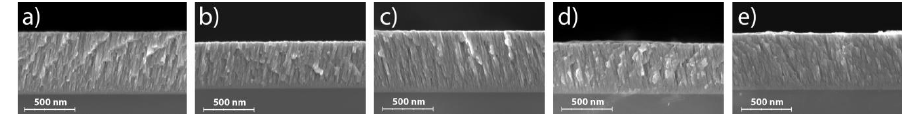
Figure 4. XRD diffractograms for points 1 – 5. The only detectable peak was the Si (400) at 69°.